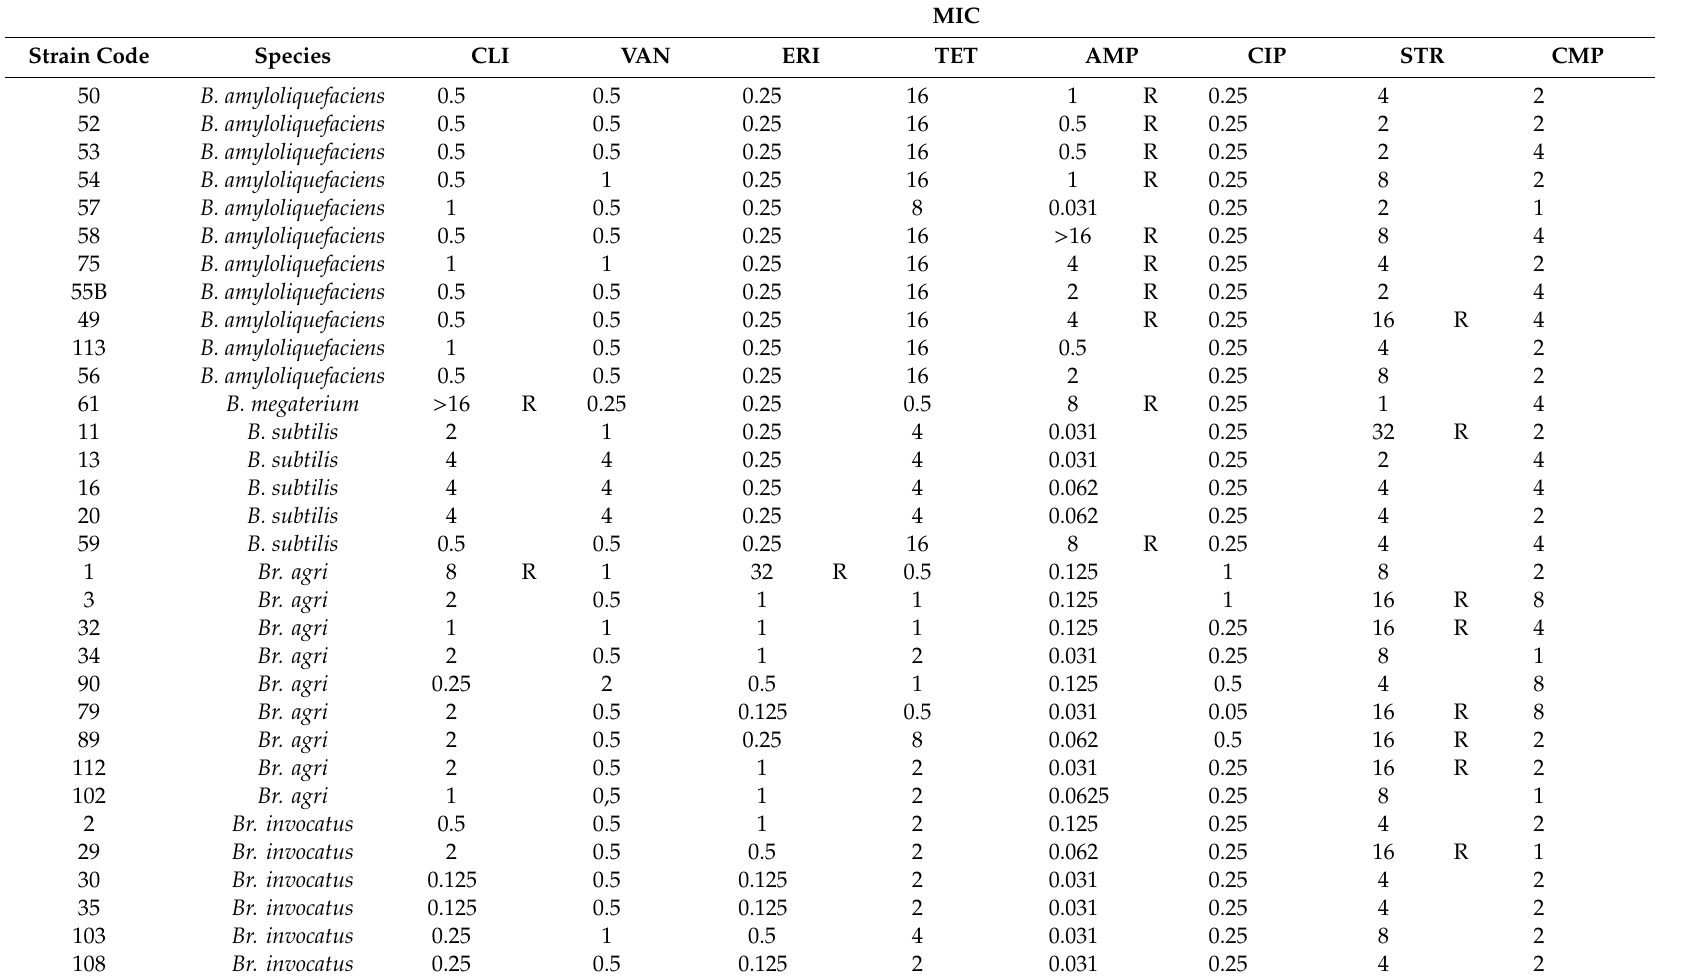
Table 5. Antibiotics suceptibility (MIC expressed in mg /